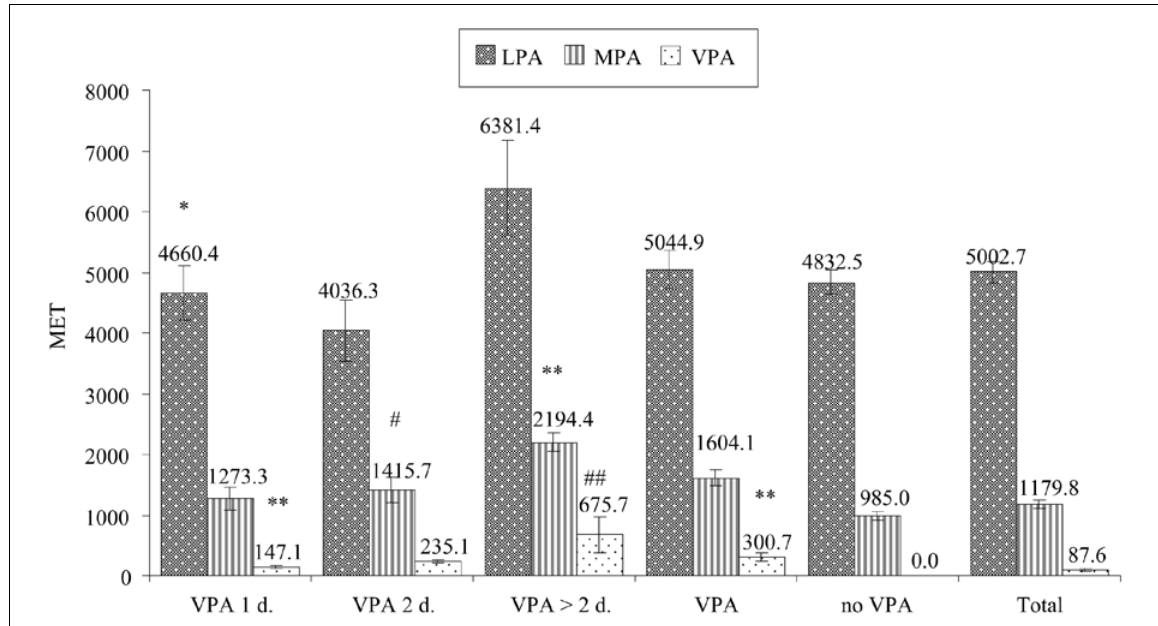
Figure. The intensity-based weekly physical activity of the adolescent boys (the participants were divided into the groups according to the frequency of the experienced VPA during the